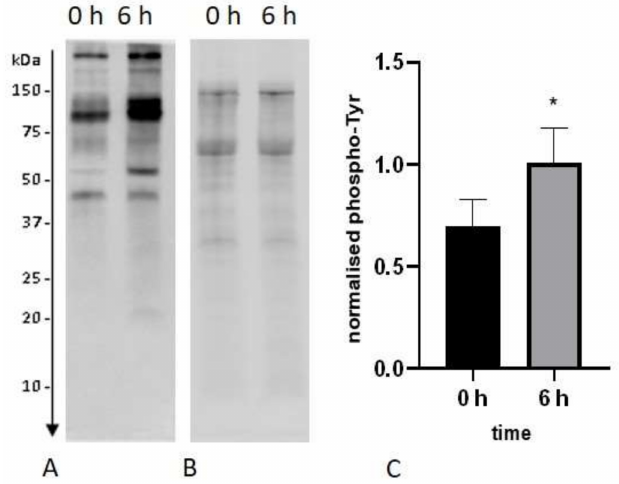
Figure 3. Western blot showing protein tyrosine phosphorylation after 0 and 6 h of incubation under capacitation-supporting conditions ( A ), stain-free image of total bull sperm proteins transferred to the membrane ( B ), protein tyrosine phosphorylation level after 0 and 6 h of incubation under capacitation-supporting conditions normalised to total proteins transferred to the membrane ( C ). * p < 0.05. Data are expressed as the mean ± SEM ( n = 8).